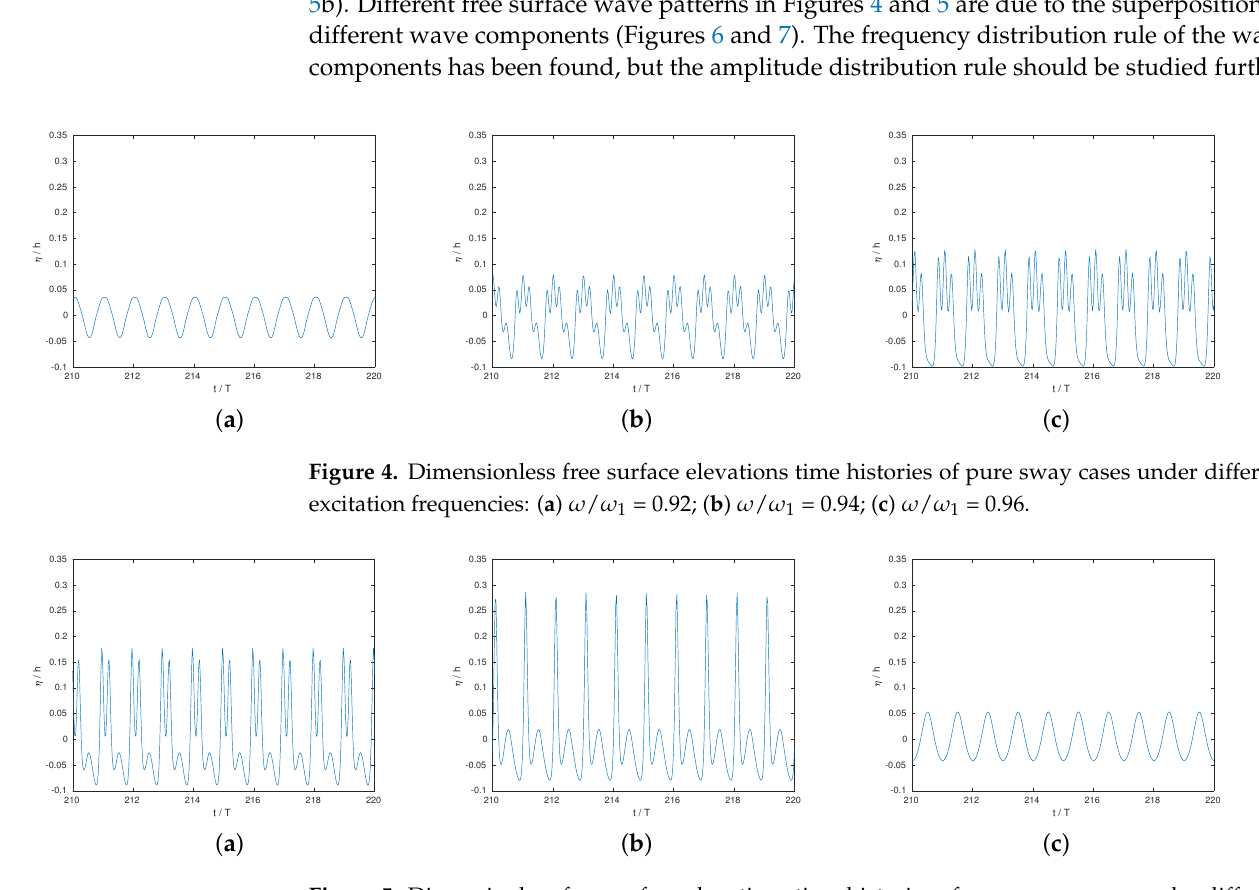
Figure 5. Dimensionless free surface elevations time histories of pure sway cases under different excitation frequencies: ( a ) ω / ω 1 = 0.98; ( b ) ω / ω 1 = 1.02; ( c ) ω / ω 1 = 1.08.